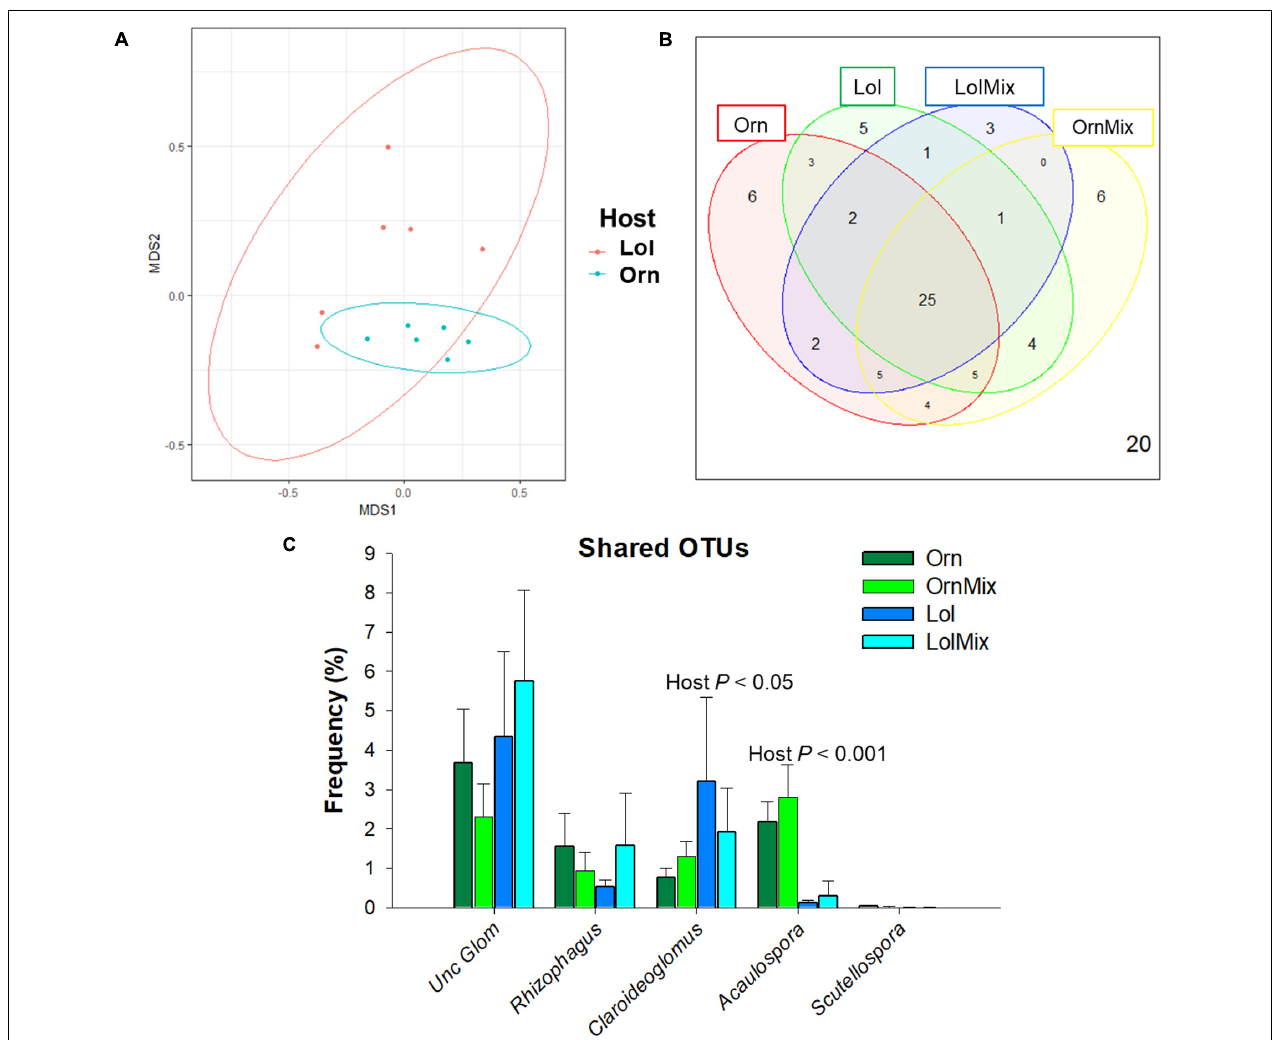
FIGURE 1 | Shared and unique OTUs between Ornithopus compressus and Lolium rigidum . (A) Representation of OTU composition in all O. compressus and all L. rigidum plants in a multidimensional space (NMDS plot), showing that they cluster depending on host. Ellipses represent ordination confidence intervals (95%) (stress = 0.13). (B) Venn diagram representing the number of unique and shared OTUs between the different hosts. (C) Frequencies of shared arbuscular mycorrhizal fungi (AMF) taxa grouped by genera in the different hosts. Significant differences between hosts for the same AMF genus ( N = 3) are indicated. In